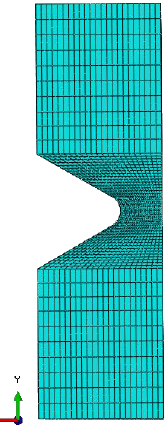
Figure 3. The meshed object used in FEA.